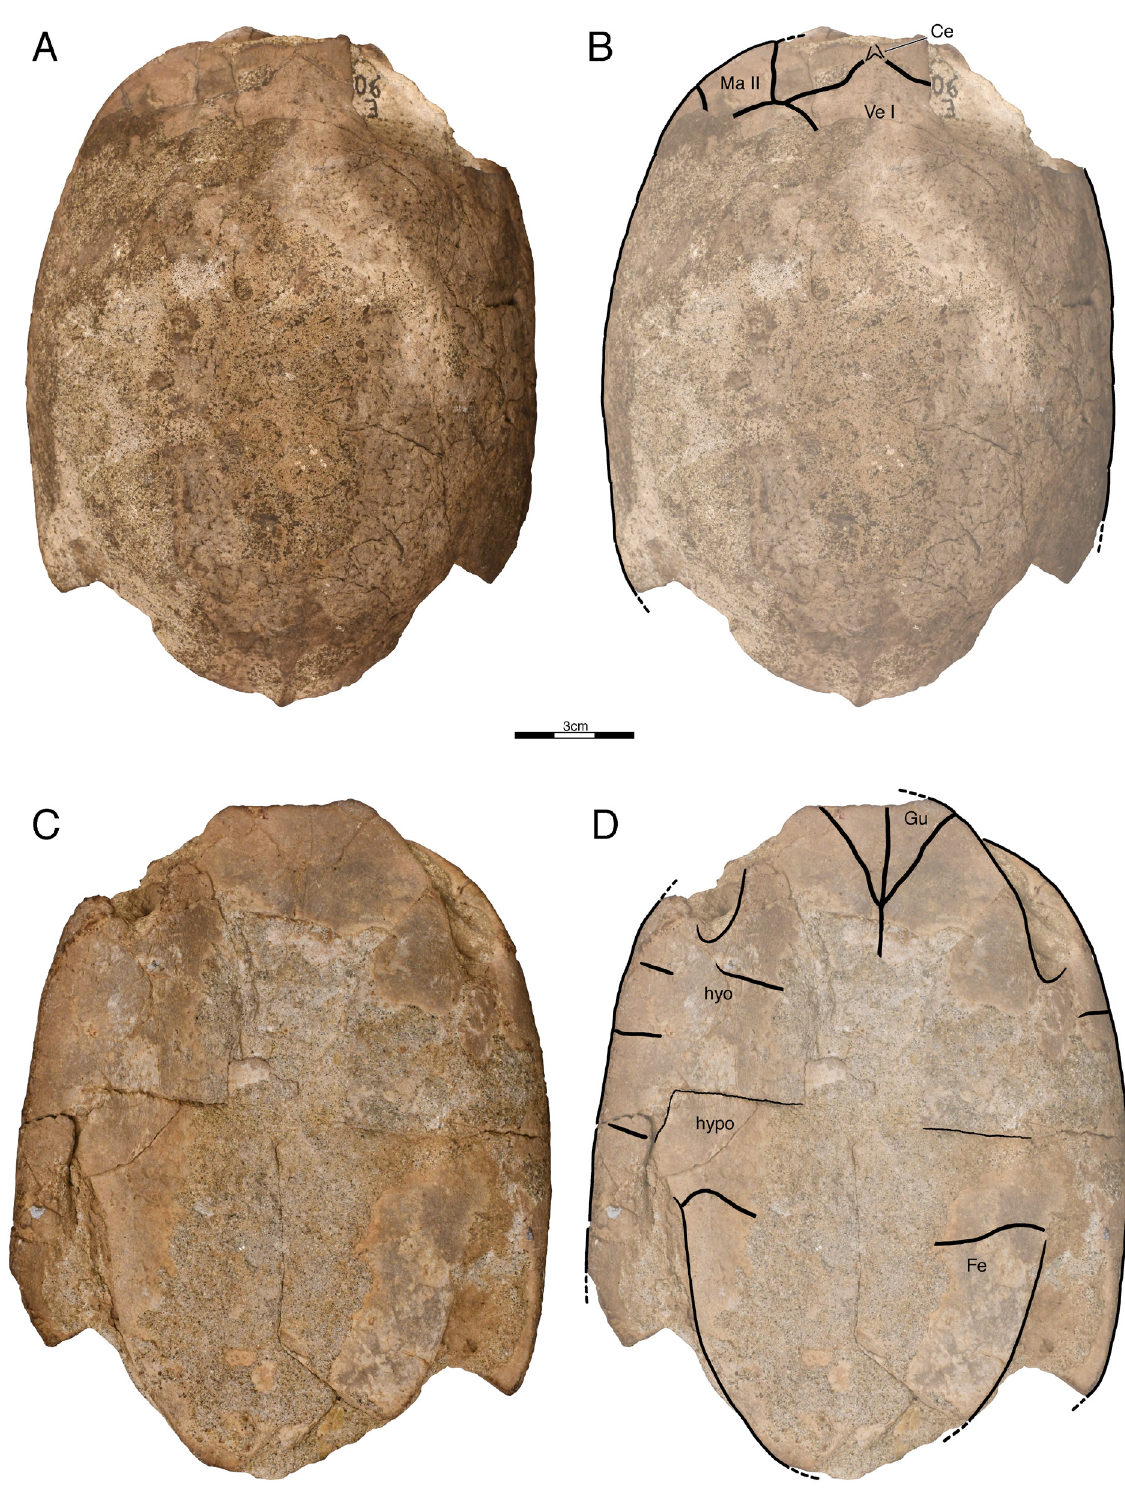
Fig. 29. IM E.90, referred to Clemmys sivalensis (Theobald, 1877) by Lydekker (1885a), here identified Melanochelys sivalensis (Theobald, 1877) comb. nov. A . Photograph of carapace. B . Illustration of carapace. C . Photograph of plastron. D . Illustration of plastron. Scale bar: 3